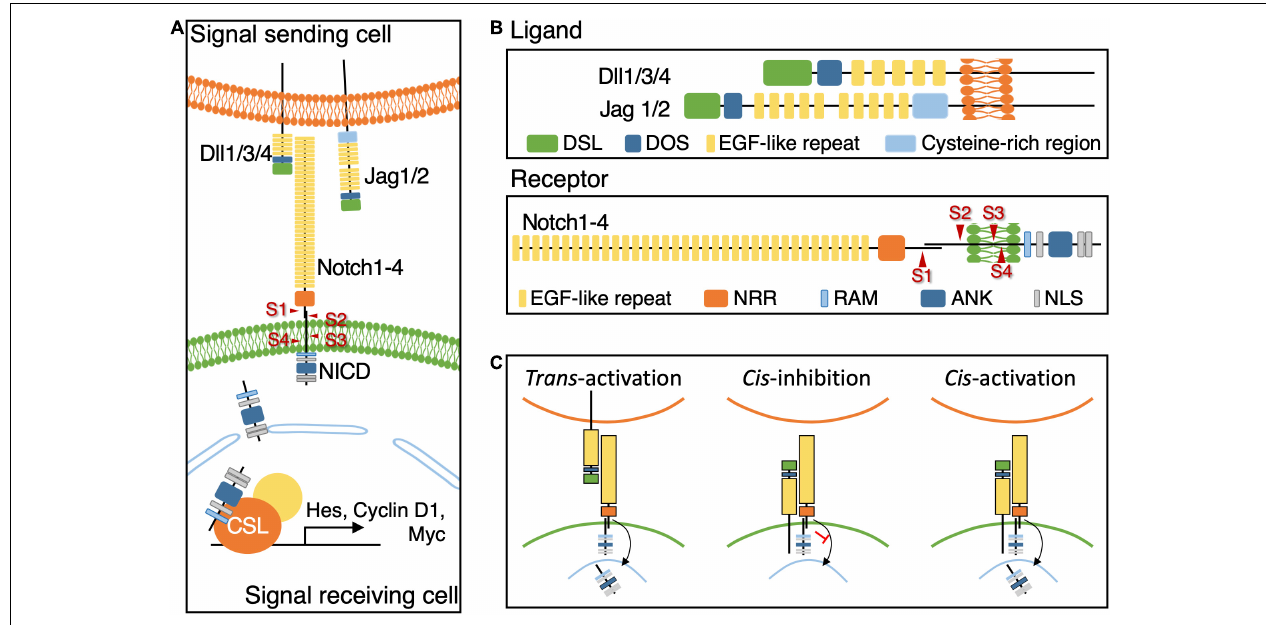
FIGURE 1 | The components and Core Notch Signaling Pathway. (A) The illustration diagram of canonical Notch signal pathway showing the crosstalk between a ligand on the signal sending cells and a receptor on the signal receiving cell triggers the cleavage of Notch receptor to release NICD fragment. Nuclear-translocated NICD fragment interacts with CSL transcription factors to activate the downstream genes. (B) The schematic diagram showing the composition of Notch ligands, Dll1/3/4 and Jag1/2, and receptors, Notch 1–4 in mammals. Arrows indicate four protease cleavage cites on Notch receptors, S1–4. (C) The schematic diagram of different regulatory processes of Notch receptor-ligand interaction. The cell membrane marked in green represent the signal receiving